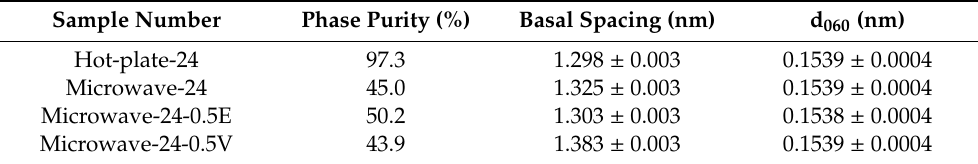
Table 1. Phase purity and basal spacing of Zn-saponite synthesized using various